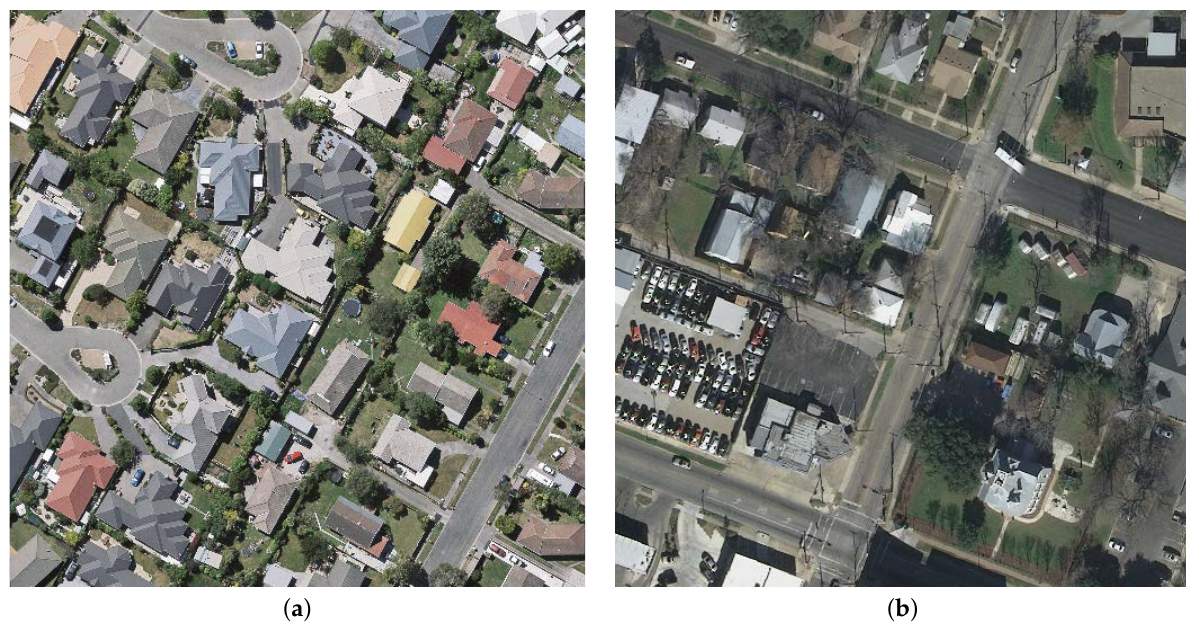
Figure 3. Samples from the Wuhan University Aerial Building Dataset ( a ) and the Inria Aerial Image Labeling Dataset ( b ). Buildings vary in size, shape and color, and may be occluded by